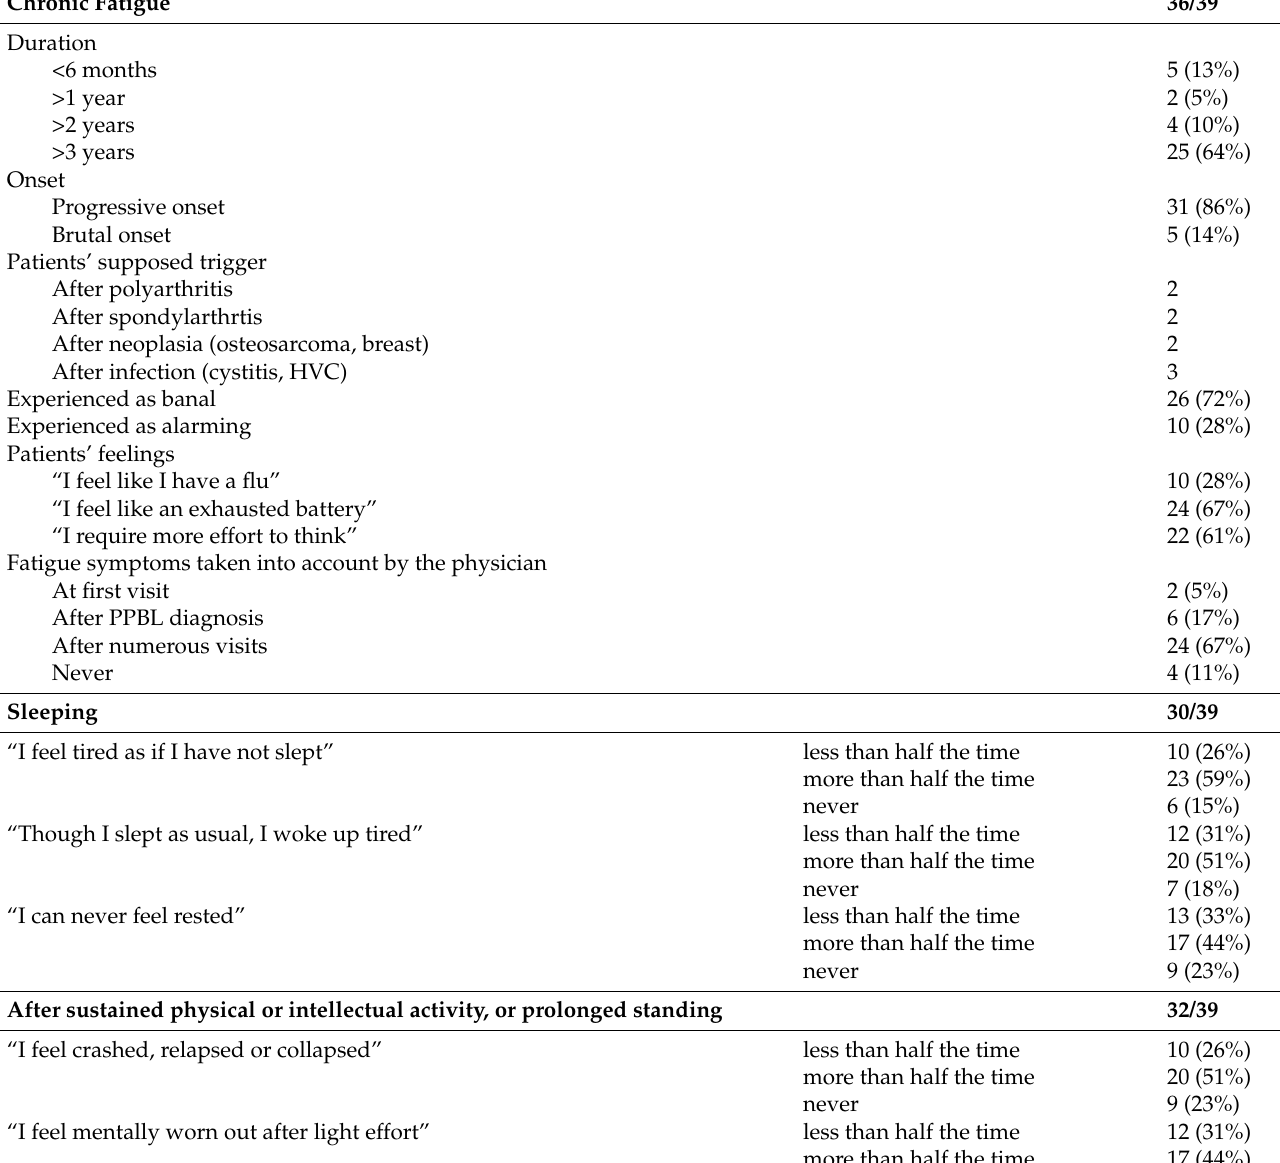
Table 2. Items explored by the